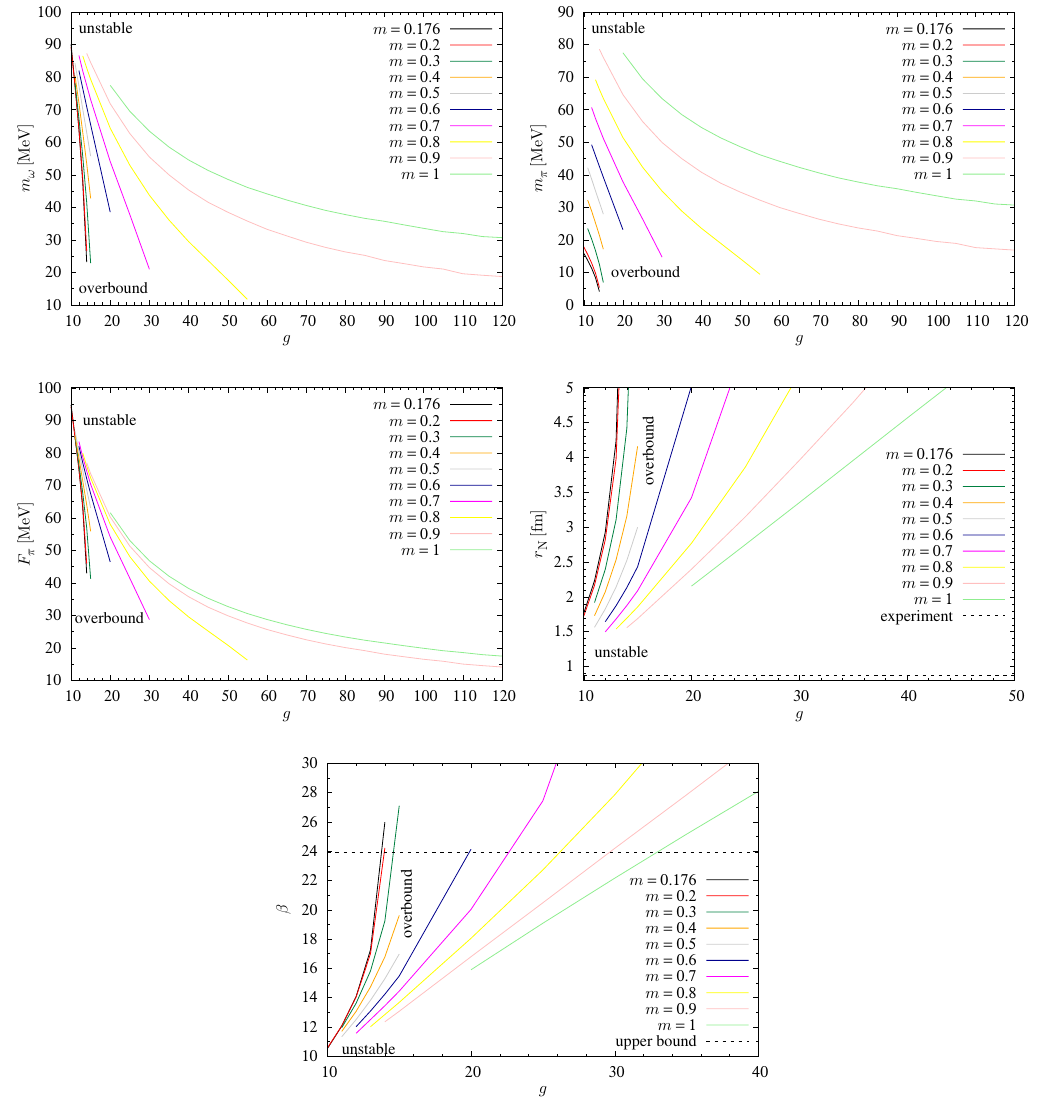
Figure 4 . Solutions that (cid:12)t to the nucleon mass and the helium-4 mass. The panels show the omega mass m ! , the pion mass m (cid:25) , the pion decay constant F (cid:25) , the nucleon radius r N and the coupling constant (cid:12) . The (cid:12)gures for r N and (cid:12) have been cropped so as to better see the viable